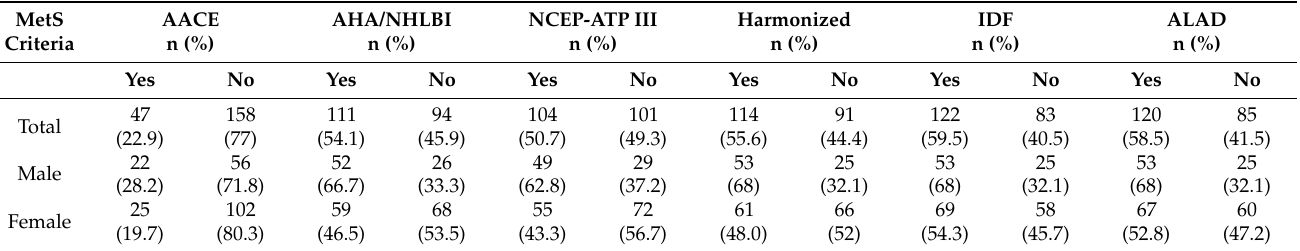
Table 3. Frequency of metabolic syndrome based on different diagnostic criteria.